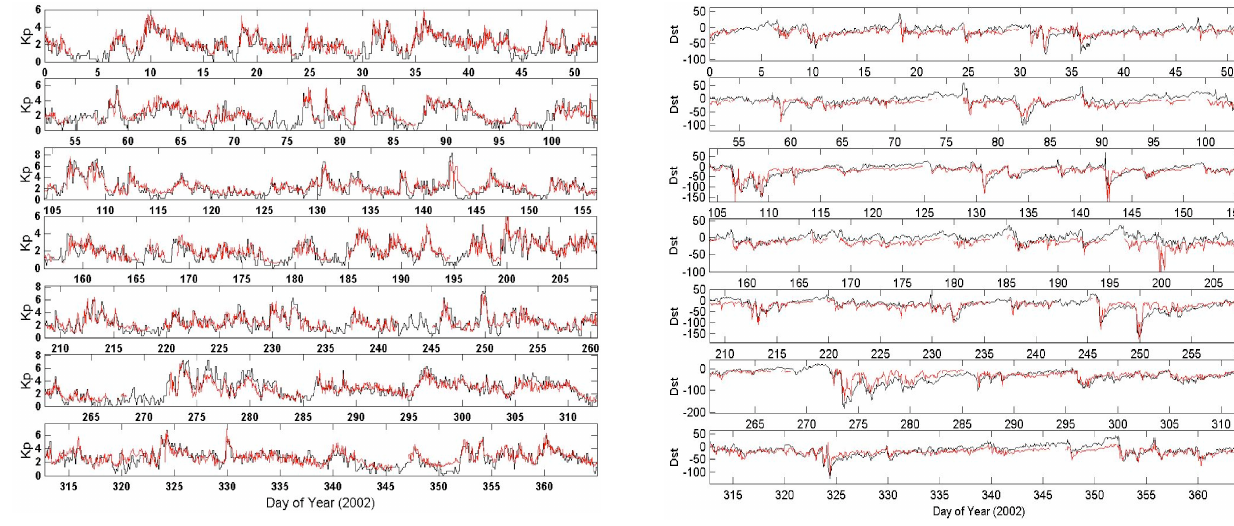
Figure 9 Fig. 9. The D st index values as a function of time in the year 2002 are specified by their corresponding driver states, in accordance with the magnetospheric state prescription of Eqs. (5) and (6). Mag- netospheric states are specified by the driver and response param- eter data obtained in 1970–2001, with K p (E2), V sw (E2), B z (E3), P sw (E2), and B tot (E2) having been localized. The estimation error is ± 16.7nT (consistent with Fig. 6c) and correlation factor with the actual data is 0.757. The black line is the actual observed D st index and red line is the estimated D st index. The gaps in the red line indicate periods of no solar wind